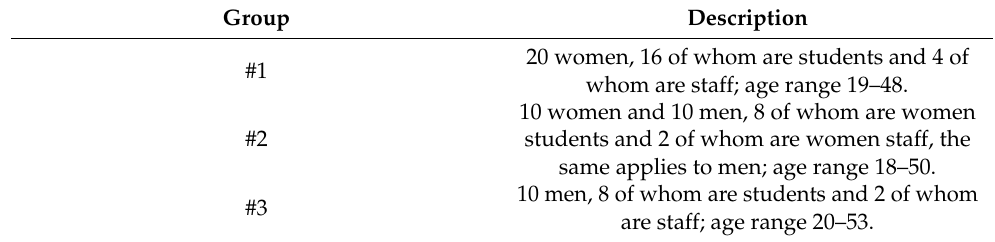
Table A1. Volunteer demographic information.